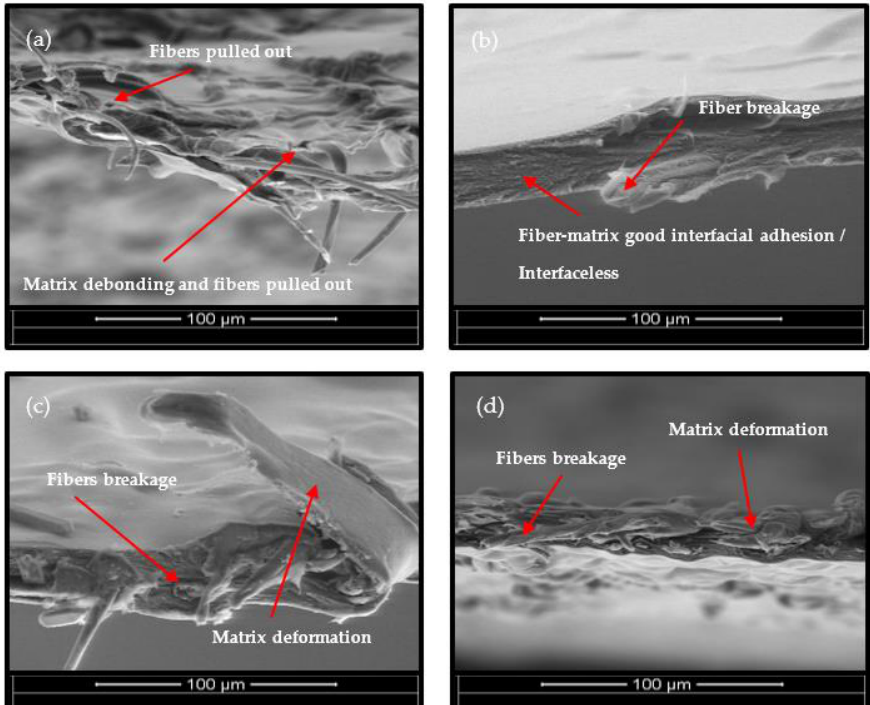
Figure 8. Cross-sectional SEM images of all-cellulose composite films at different dissolution times: ( a ) ACC5, ( b ) ACC15, ( c ) ACC30, and ( d ) ACC45. (magnification ×500).